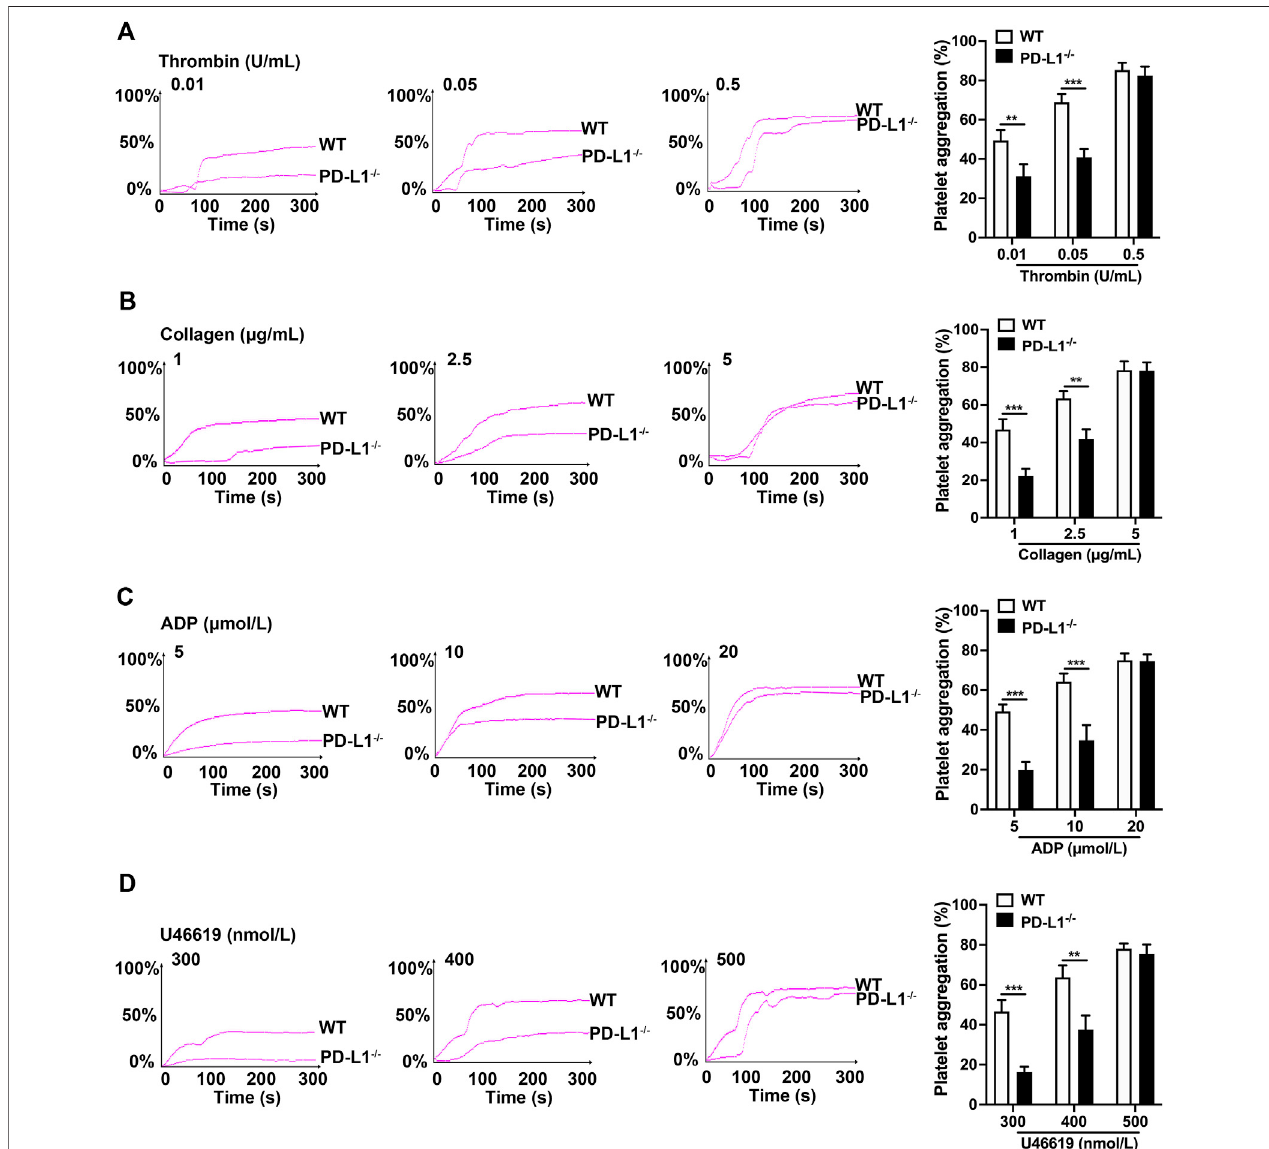
FIGURE 2 | PD-L1 knockout reduces platelets aggregation in responded to the stimulations of thrombin, ADP, collagen, and U46619. Platelet-rich plasma from WTorPD-L1 − / − micewerestimulatedwithdifferentconcentrationsofthrombin(0.01,0.05or0.5U/ml) (A) ,collagen(1,2.5or5 μ g/ml) (B) ,ADP(5,10or20 μ mol/ml) (C) , and U46619 (300, 400 or 500 nmol/ml) (D) at 37 ° C to detect aggregation using the AG400 semi-automatic platelet aggregation analyzer for 5 min. Aggregation was expressedasthemaximalpercentageoflighttransmitted.Thegraphsarerepresentativeexperiments.Inthehistogramsofmaximalplateletsaggregationunderthe indicated conditions. Data are mean ± SD; n = 5, ** p < 0.01, *** p <